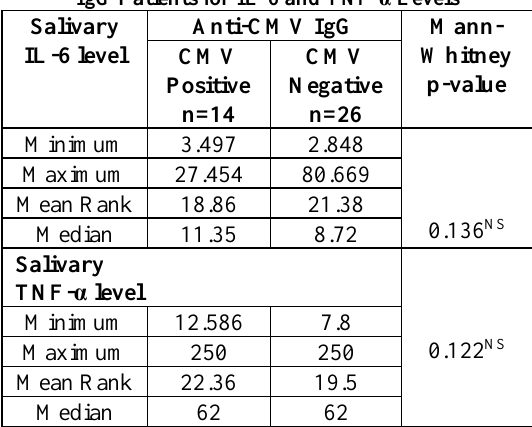
Table 7: Comparison between Positive and Negative IgG Patients for IL-6 and TNF-α Levels